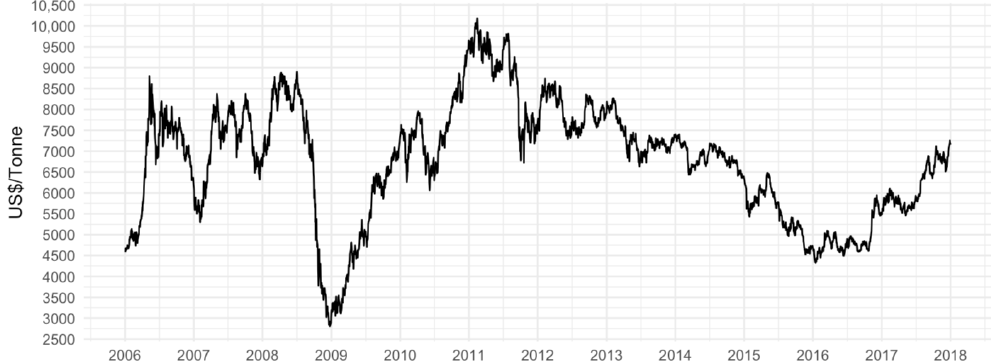
Figure 2. Evolution of time series of the closing copper price in LME, from January 2006 to January